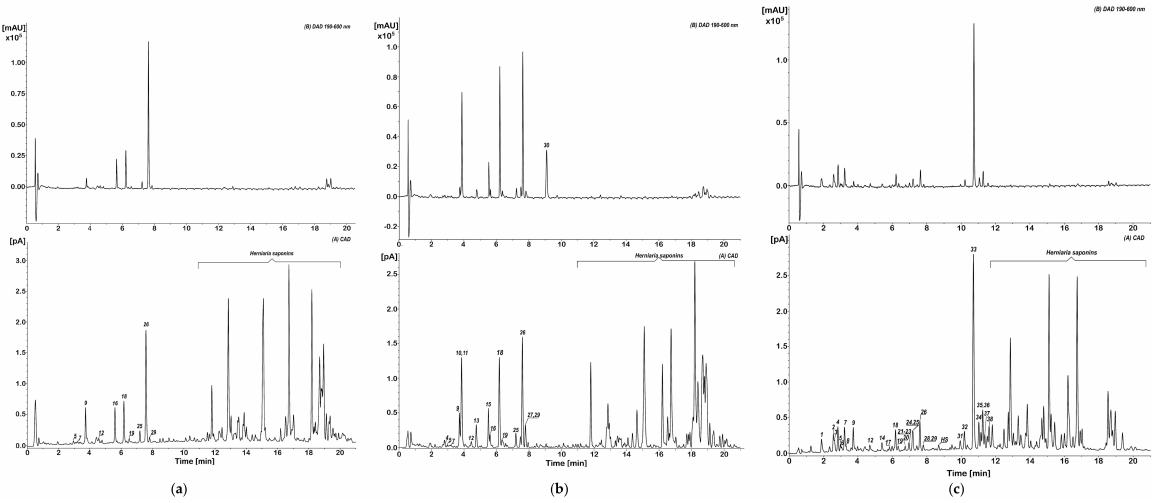
Figure 2. UHPLC—diode array detector (DAD) and charged aerosol detector (CAD) profiles of the purified extracts from ( a ) Herniaria glabra ; ( b ) H. polygama ; ( c ) H. incana